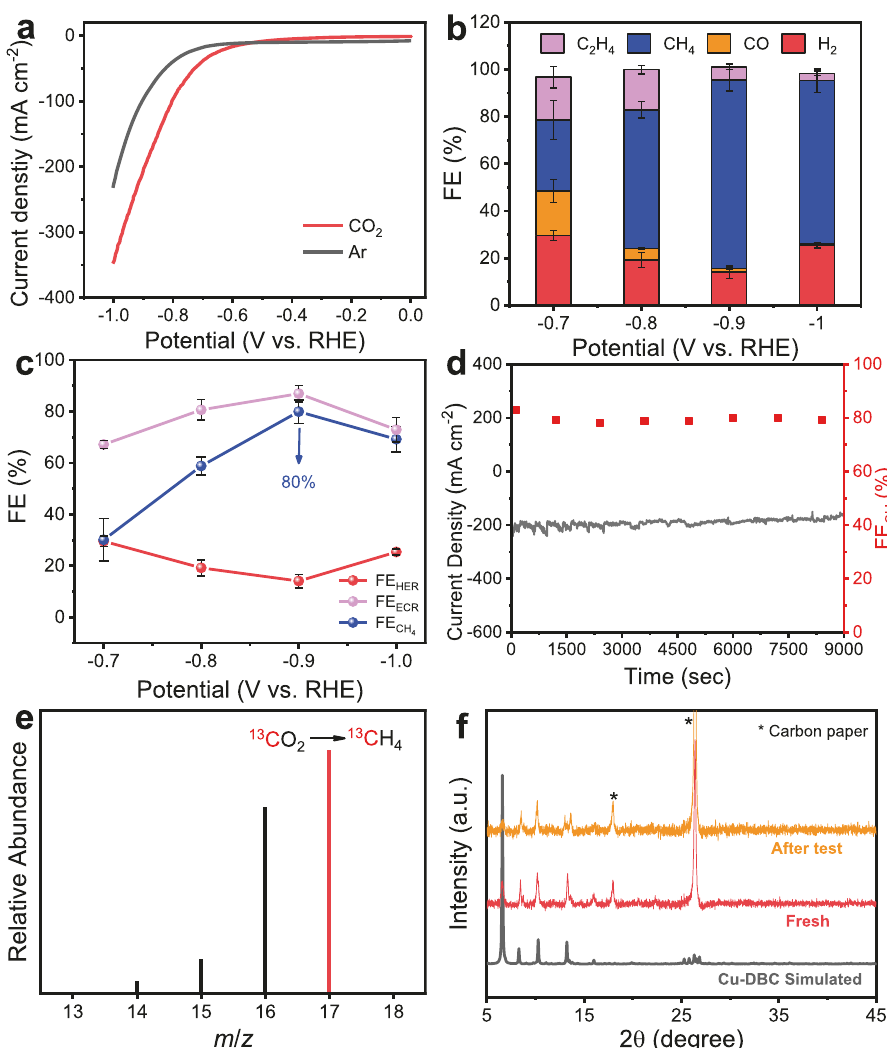
Fig. 2 ECR-to-CH 4 performance of Cu-DBC electrocatalyst. a Polarization curves recorded under CO 2 and Ar. b Faradaic ef fi ciencies (FEs) of ECR products at different applied potentials. c FEs for HER, ECR, and CH 4 recorded at different applied potentials. d Current pro fi le and FEs of CH 4 at a constant voltage of − 0.9 V vs. RHE. e The mass spectra of 13 CH 4 recorded under 13 CO 2 atmosphere. f XRD patterns of fresh and tested Cu-DBC modi fi ed GDL- carbon paper